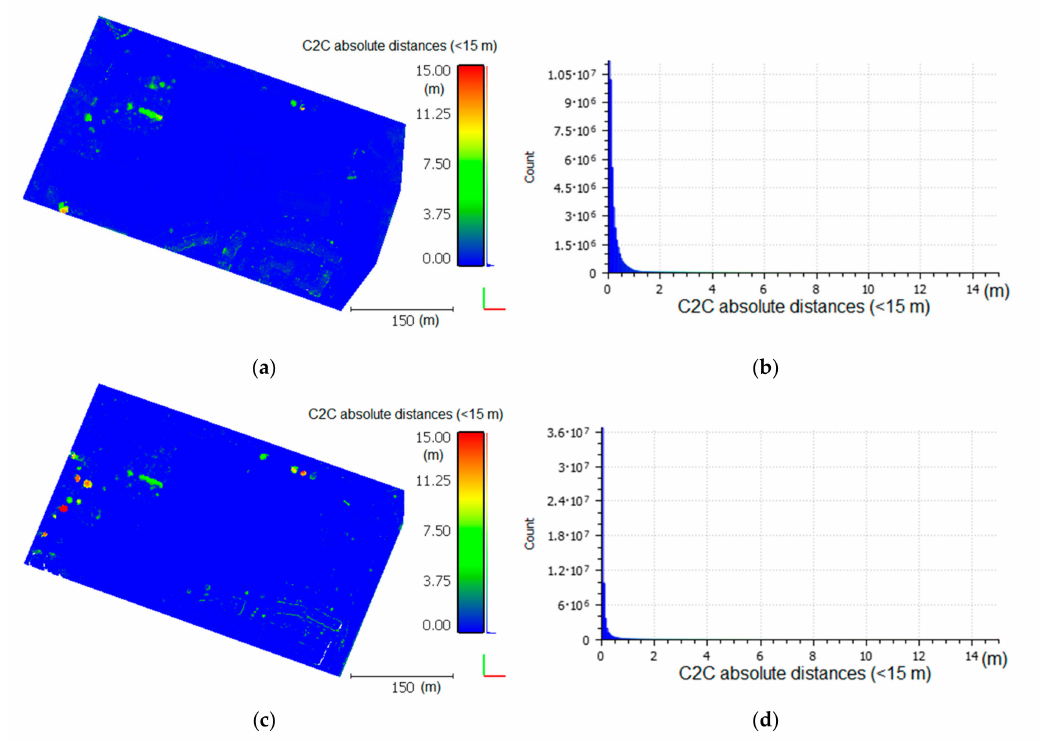
Figure 7. Point-to-point cloud comparison of the Mavic Pro: ( a ) scalar field 55 m to SR and ( b ) histogram 55 m to SR and Phantom 4 Pro: ( c ) scalar field 55 m to SR and ( d ) histogram 55 m to SR [97]. C2C: